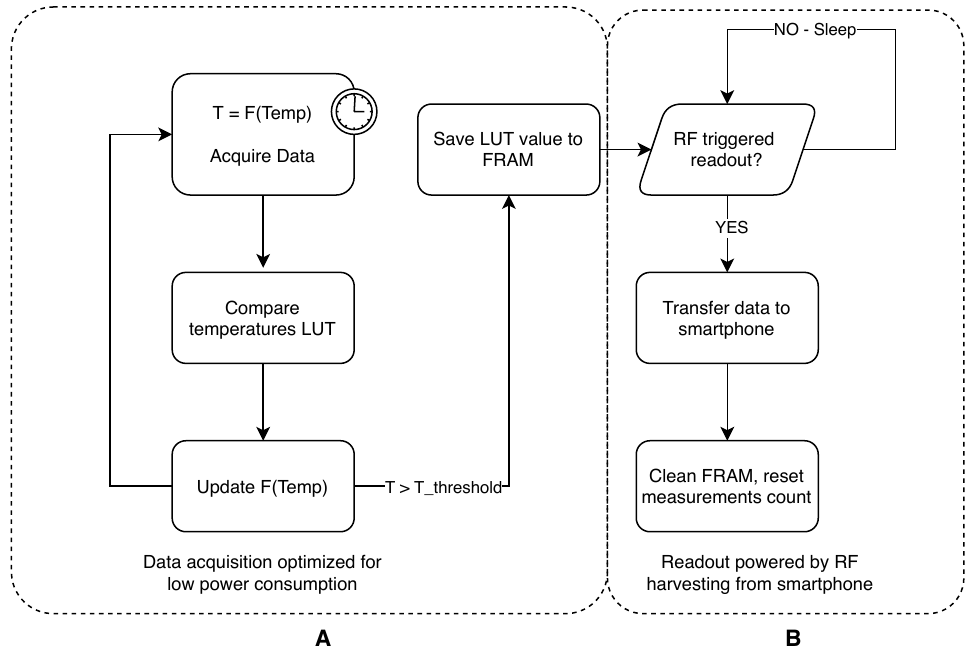
Figure 8. Overall diagram of the software. ( A ) data acquisition algorithm; ( B ) NFC readout